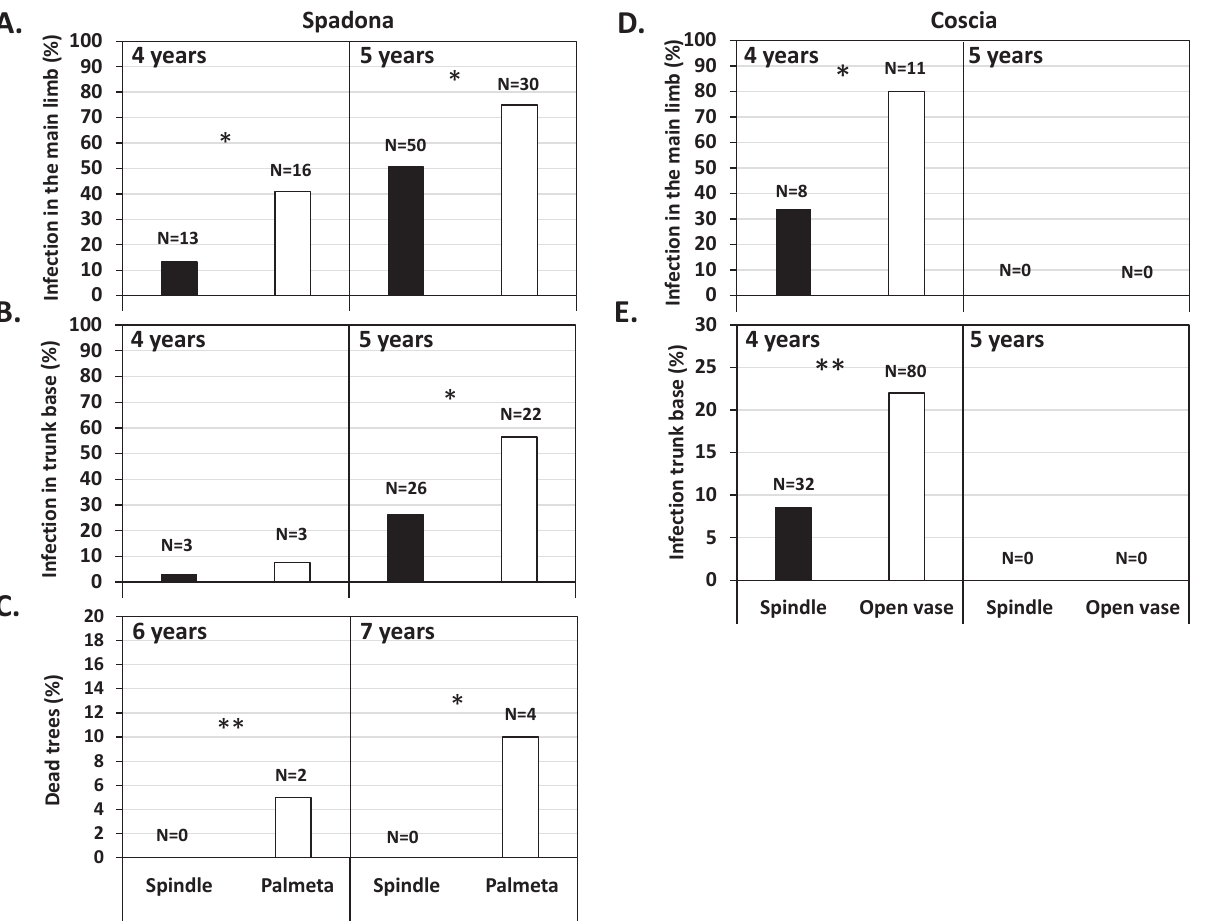
Figure 3. Mean proportions of pear trees infected with Erwinia amylovora out of all trees of different growth designs. A to C, ‘Spadona’ grown in spindle design (low vigour, high density) or palmeta design (high vigour, low density). D and E, ‘Coscia’ grown in spindle or open vase designs (high vigour, low density). A and D, Percent of trees with infections that reached the main limbs. B and E, percent of trees with infections that reached the trunk bases. C, percent of dead trees. Note that only ‘Spadona’ trees growing in the palmeta design (high vigour, low-density system) died due to fire blight. N = number of infected or dead trees. * P < 0.01, ** P < 0.05 as indicated from contingency Chi- square